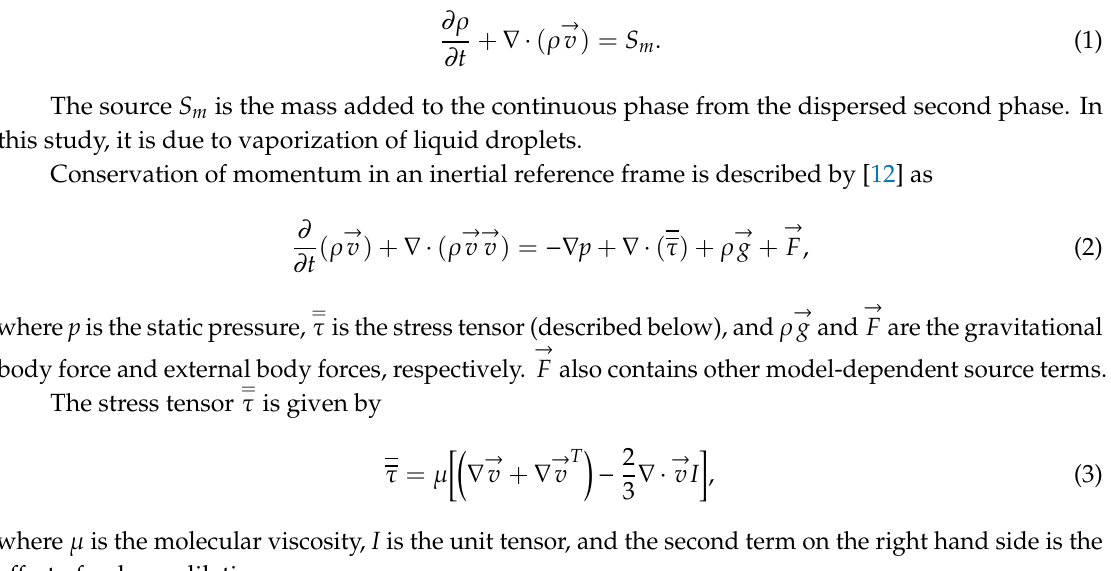
Figure 1. ( a ) shows the cylindrical regional grids and ( b ) shows the structure of the two mixing